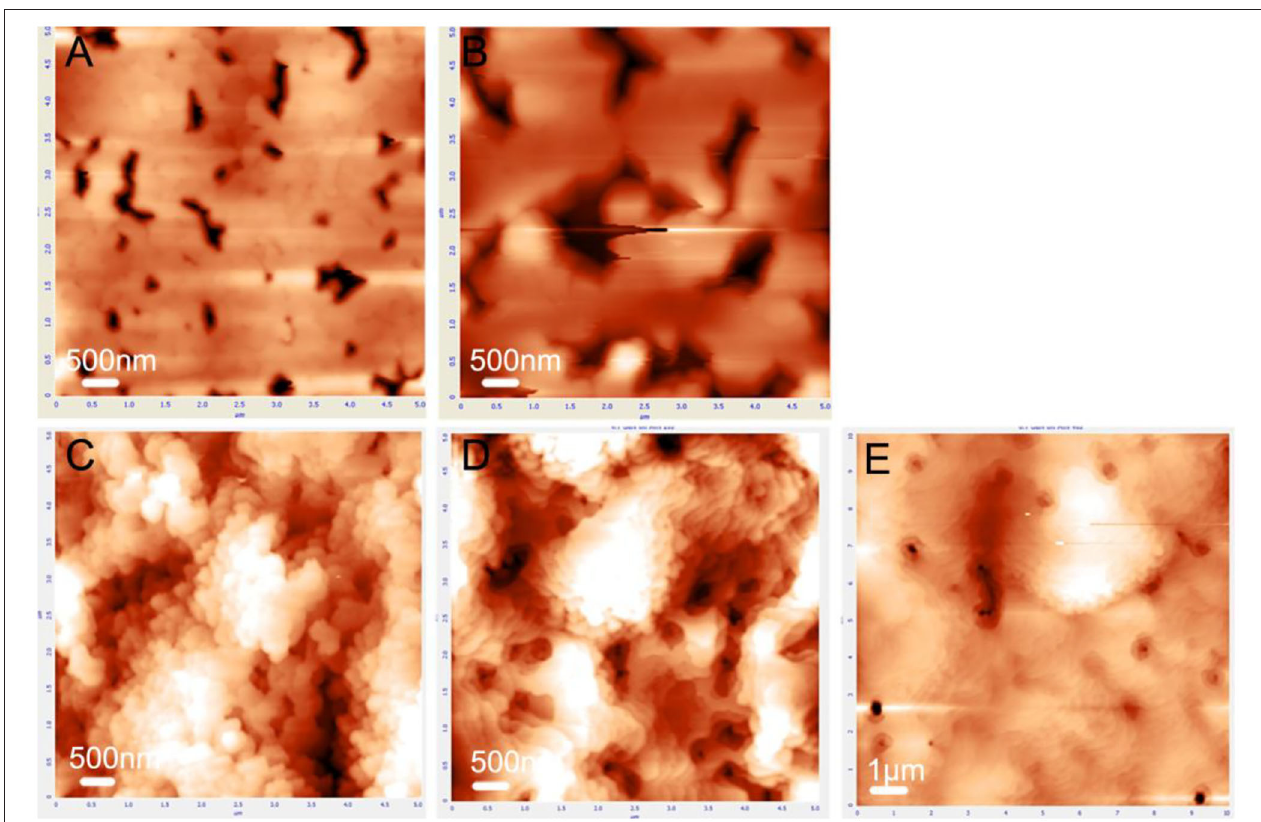
FIGURE 4 | AFM images of GaN nucleation layer of sample A (A,B) and sample B (C–E) . Nucleation layer growth times were set to 10s for (A,C) , 20s for (B,D) , and 40s for (E)